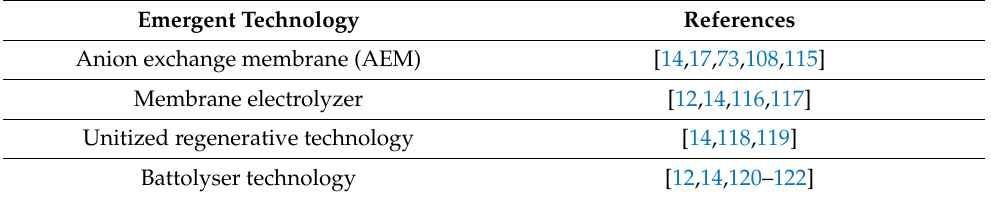
Table 7. Related references for emergent technologies for seawater electrolysis. Emergent Technology